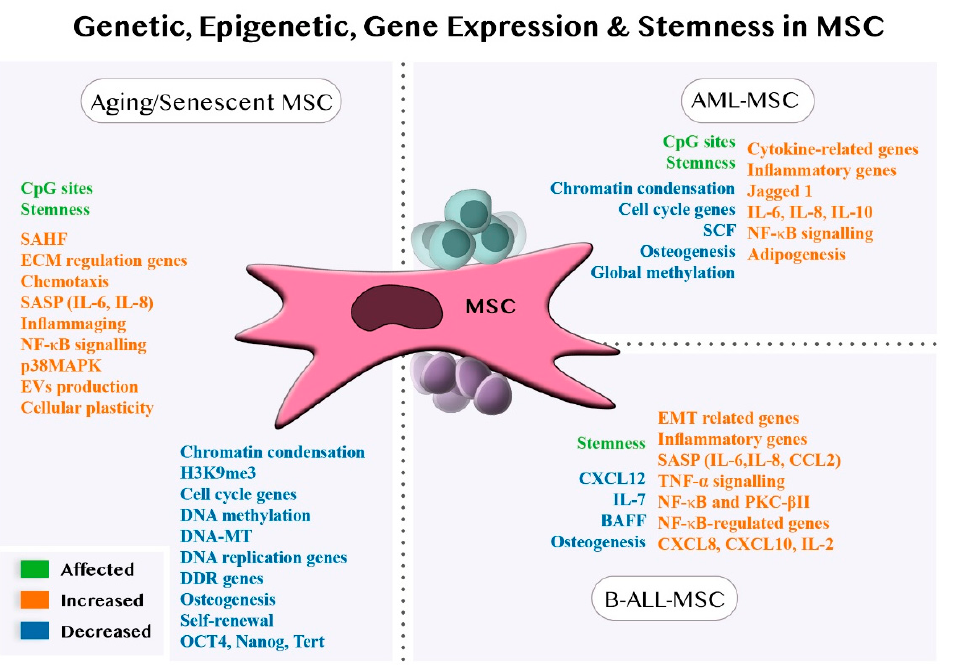
Figure 2. Expression profile, genetic, epigenetic and stemness-related changes in MSCs. Regarding the repertoire of soluble factors and cytokines, aged MSCs and leukemic MSCs show a proinflammatory signature mediated, in part, by NF- κ B activation. Other genes related to replicative or proliferative capacities are repressed by changes in the epigenetic landscape, even though global DNA methylation is reduced. Stemness functions involving self-renewal, clonogenicity and differentiation potential are also impaired in both disease models. DNA-MT: DNA methyl transferases; ECM: extracellular matrix; EVs: extracellular vesicles.